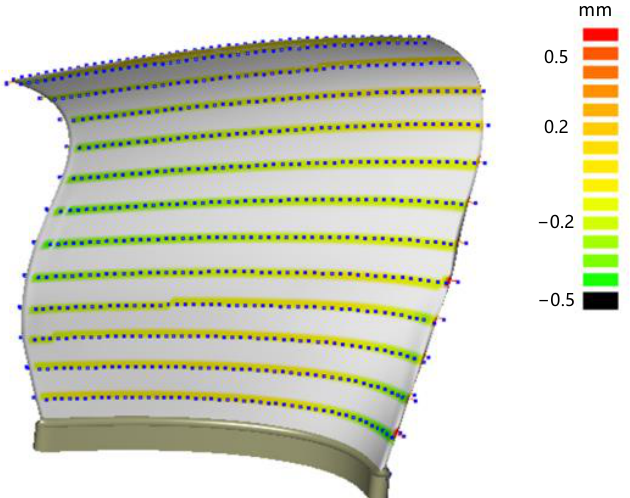
Figure 9. Material distribution on the to-be-cut blade surface by unconstrained optimization.